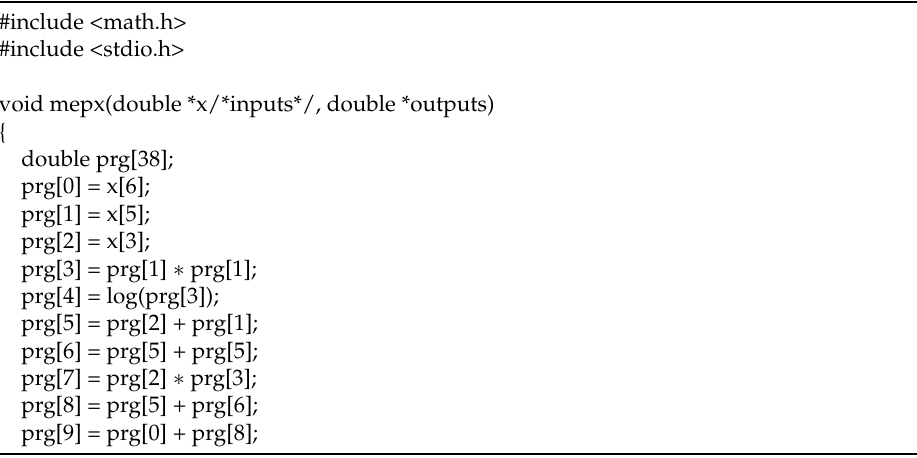
Table A1. A-1: MEP generated code for prediction of Electric Conductivity